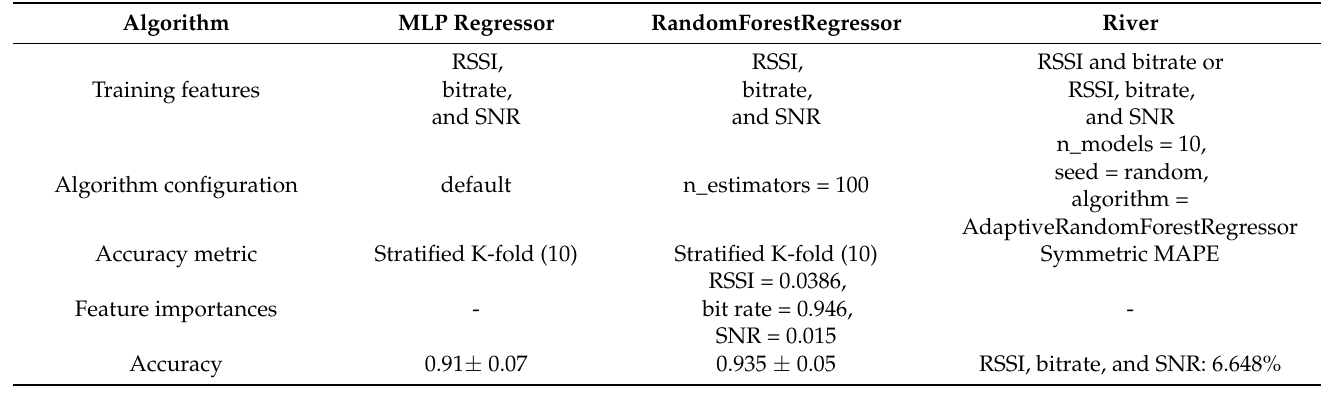
Table 1. Offline accuracy/efficiency of different ML algorithms.